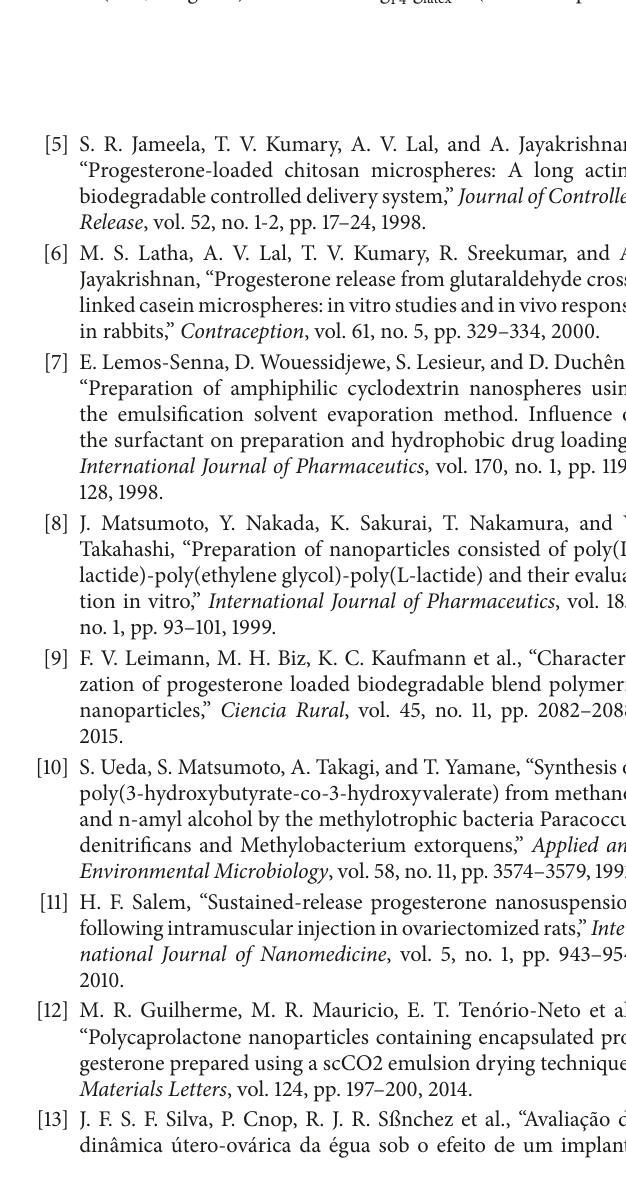
−1 (NS: nanospheres; ⋅ g latex P 4